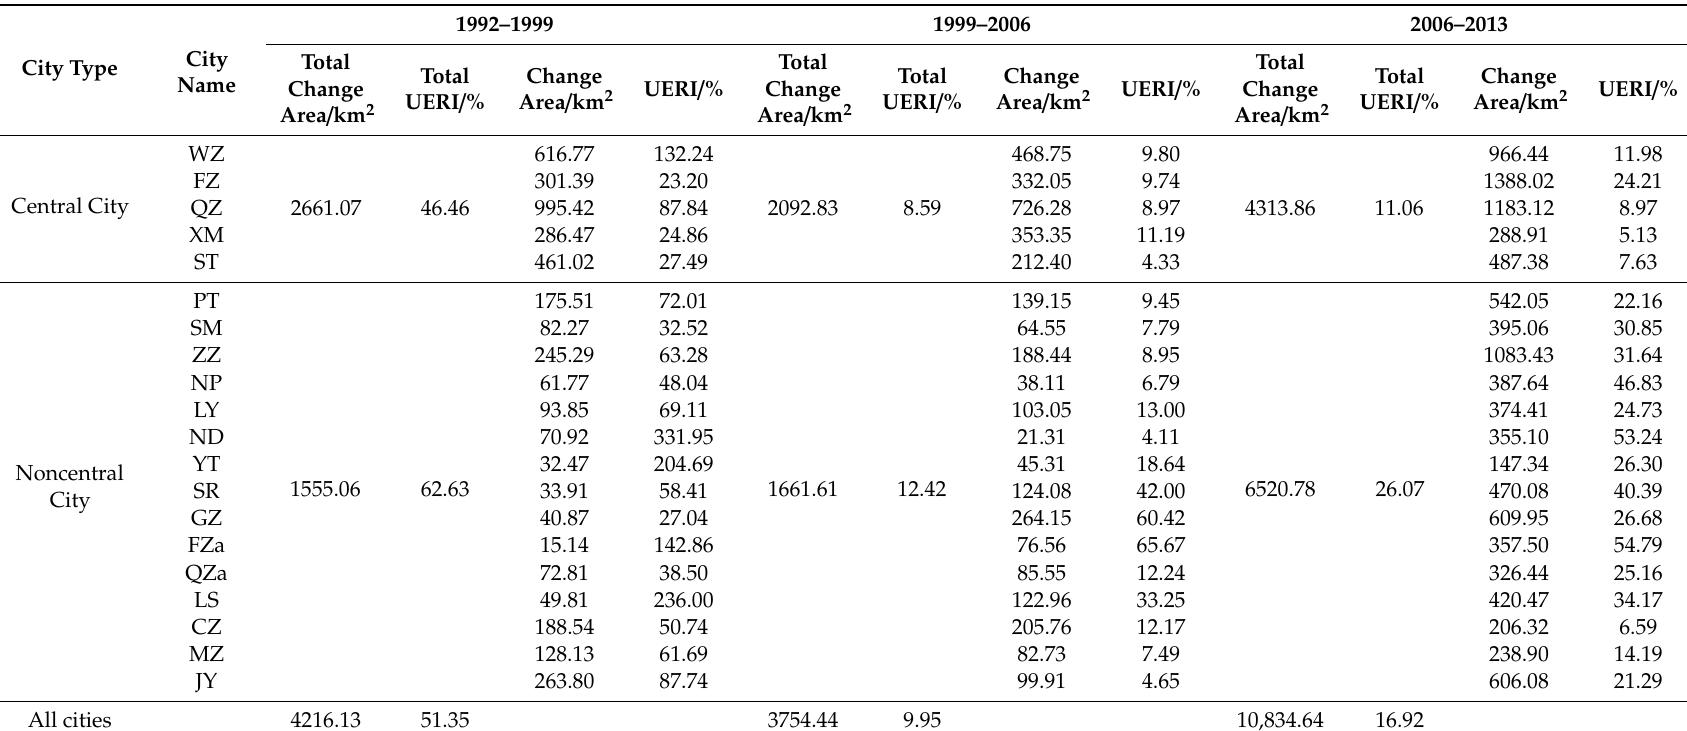
Table 4. Changes in area and expansion rate of urban areas for di ff erent city types in the